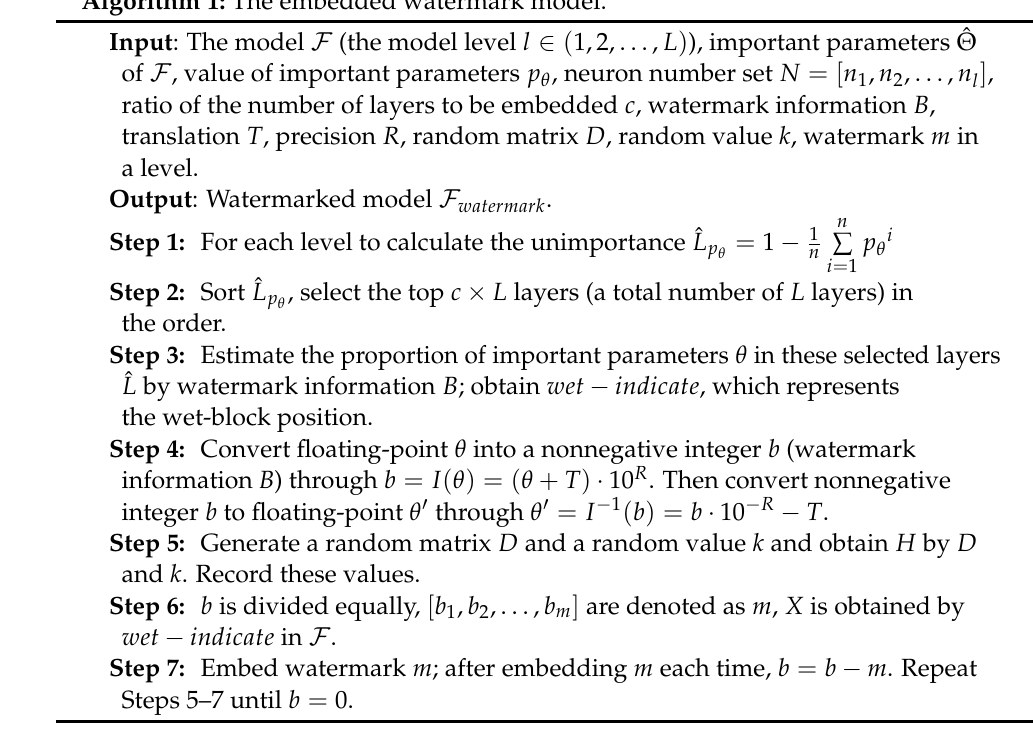
Algorithm 1: The embedded watermark model.